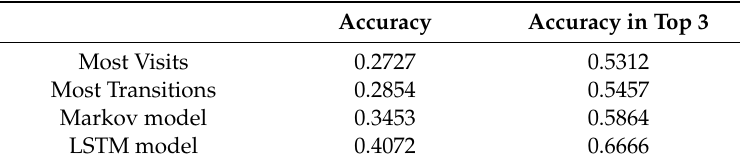
Table 2. Overall performance